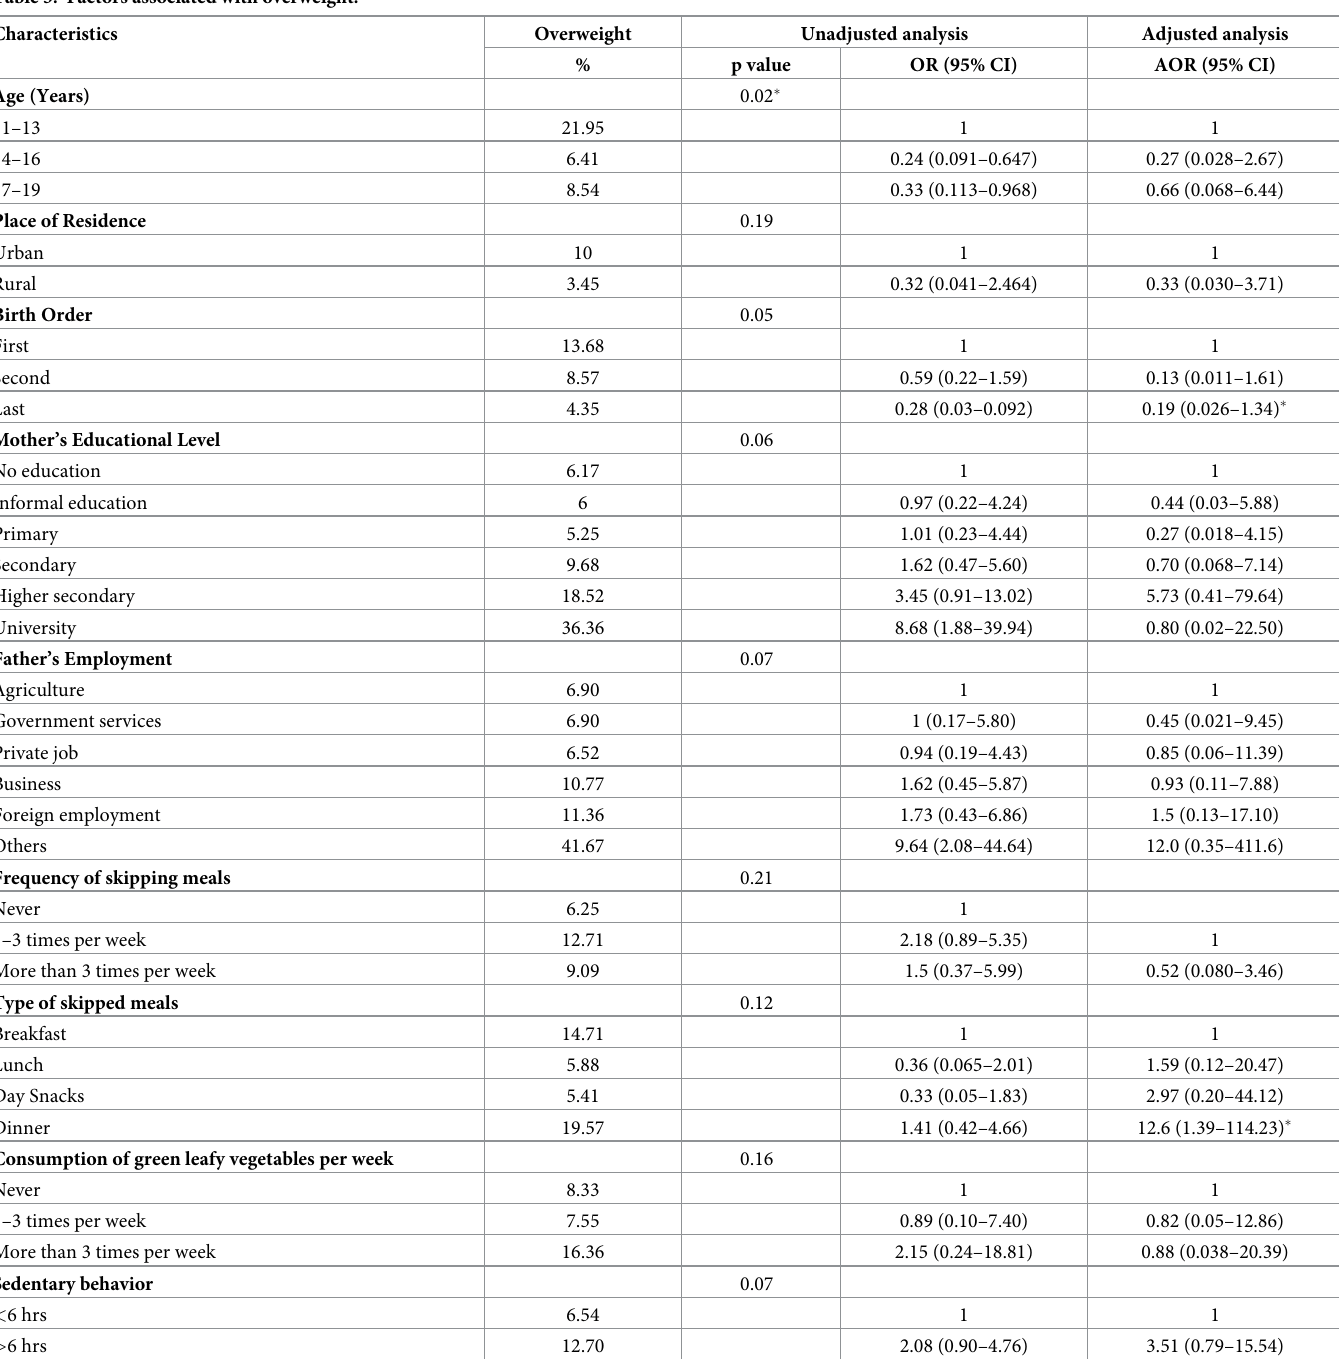
Table 3. Factors associated with